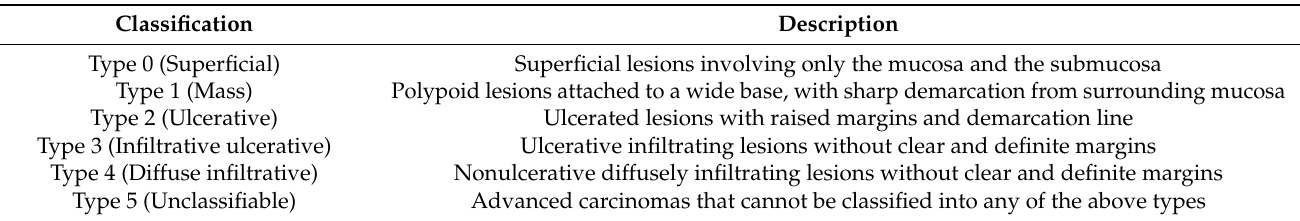
Table 1. Japanese macroscopic